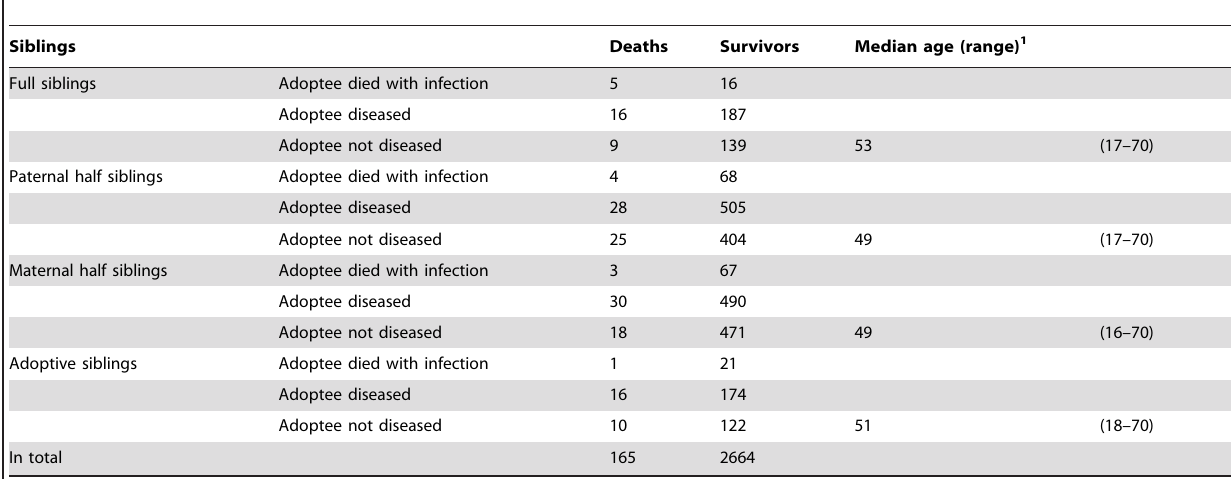
Table 2. The 2829 diseased siblings divided into deaths and survivors by disease status of the adoptee (95 adoptees deaths with infections, 827 diseased adoptees and 698 not diseased